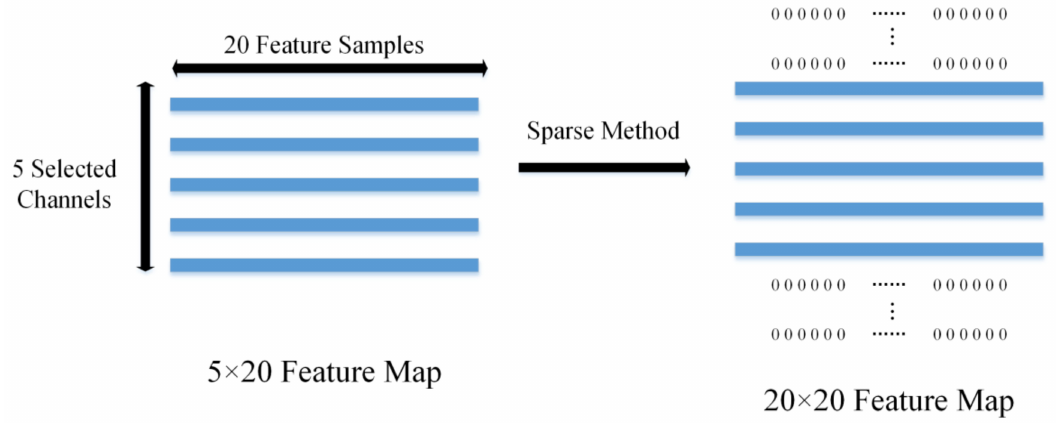
Figure 8. The changes of EEG feature